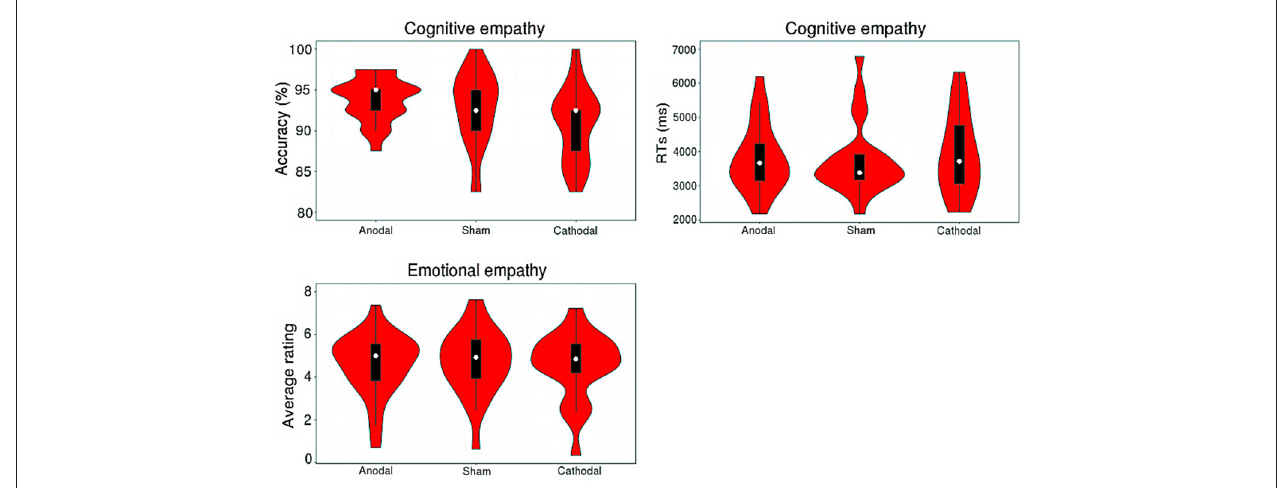
FIGURE 4 | Distribution of the accuracy and response times (RTs) of cognitive empathy and the average rating for emotional empathy for all participants of three stimulations.